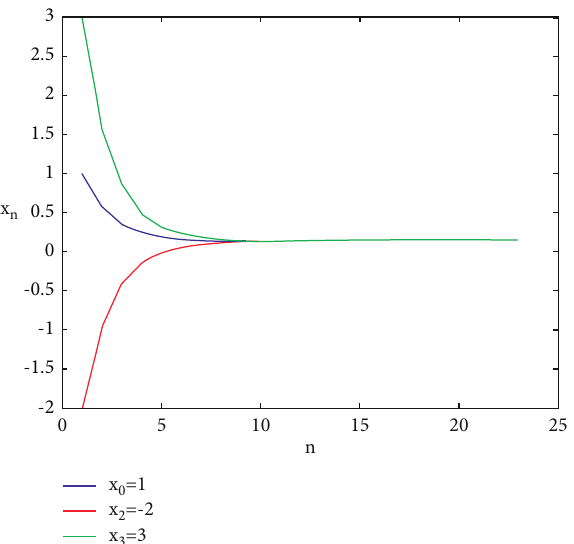
Figure 4: By combining all the above graphs, we get the following conjoining graph of